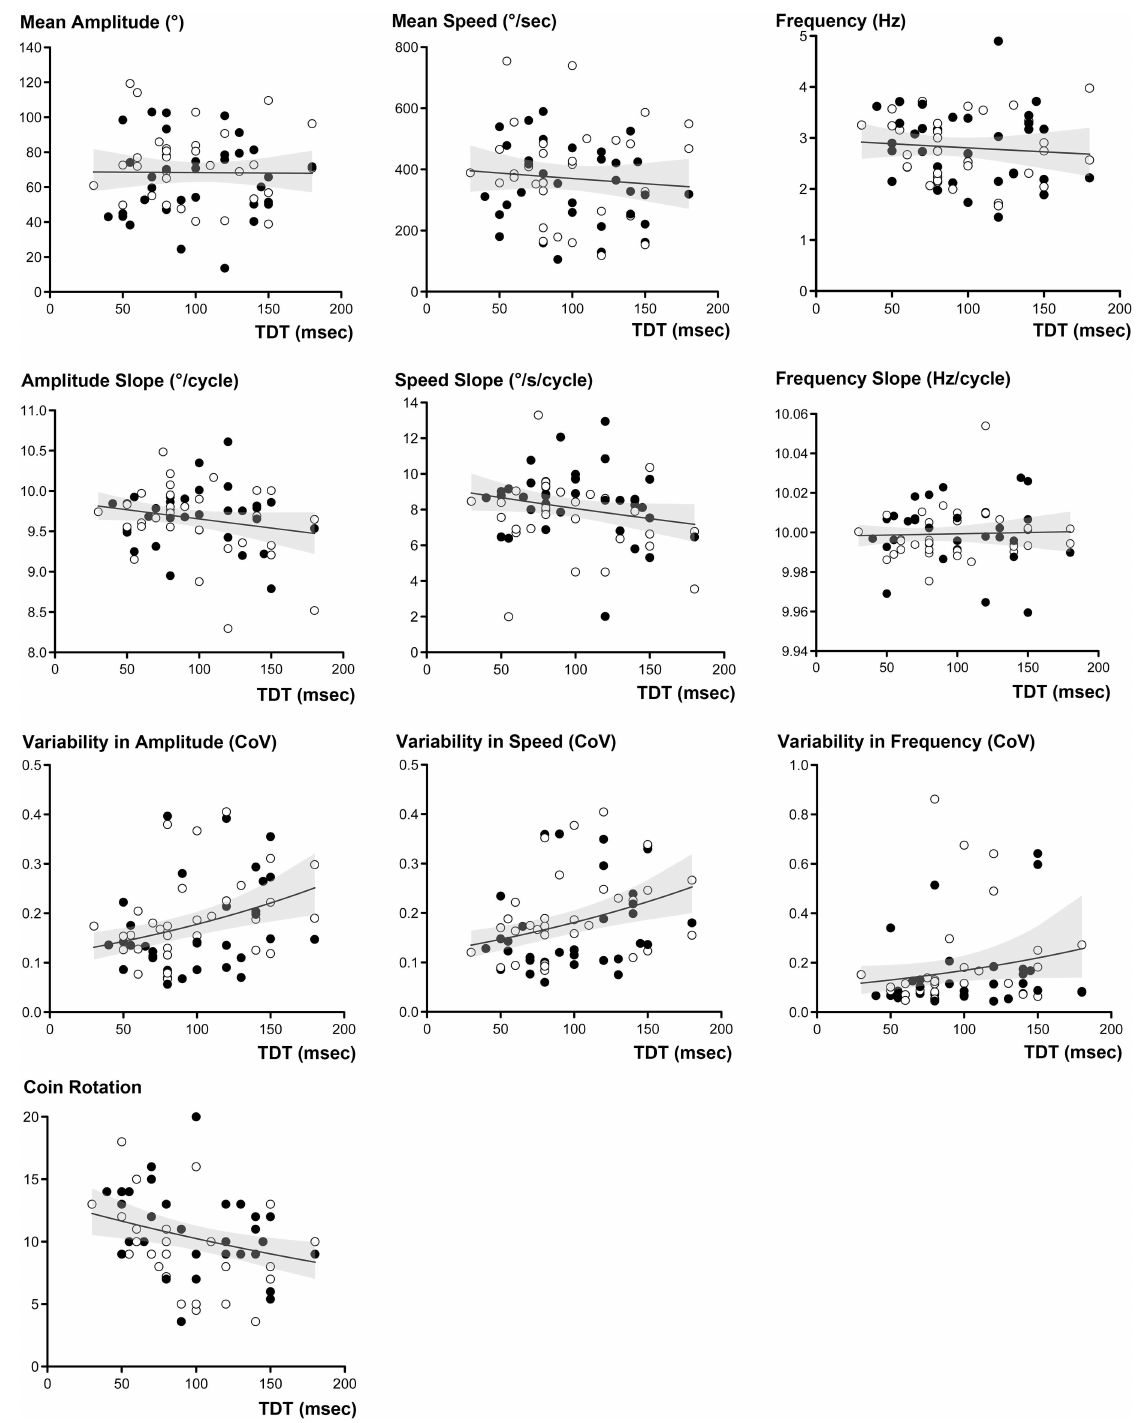
Fig 1. Scatter plots showing the relationship between TDT values and finger movement-related parameters in PD group. Slope-related parameters were transformed to positive values by addinga constant (+10). Open circles represent the left side hand and filled circles represent the right side hand. The fitted line representsthe predictedmean responsein the GEE model (predictor= TDT values, response = finger movement-relatedparameters), and the shaded area indicates95% confidence interval. TDT = temporaldiscrimination threshold; CoV = coefficient of variance)